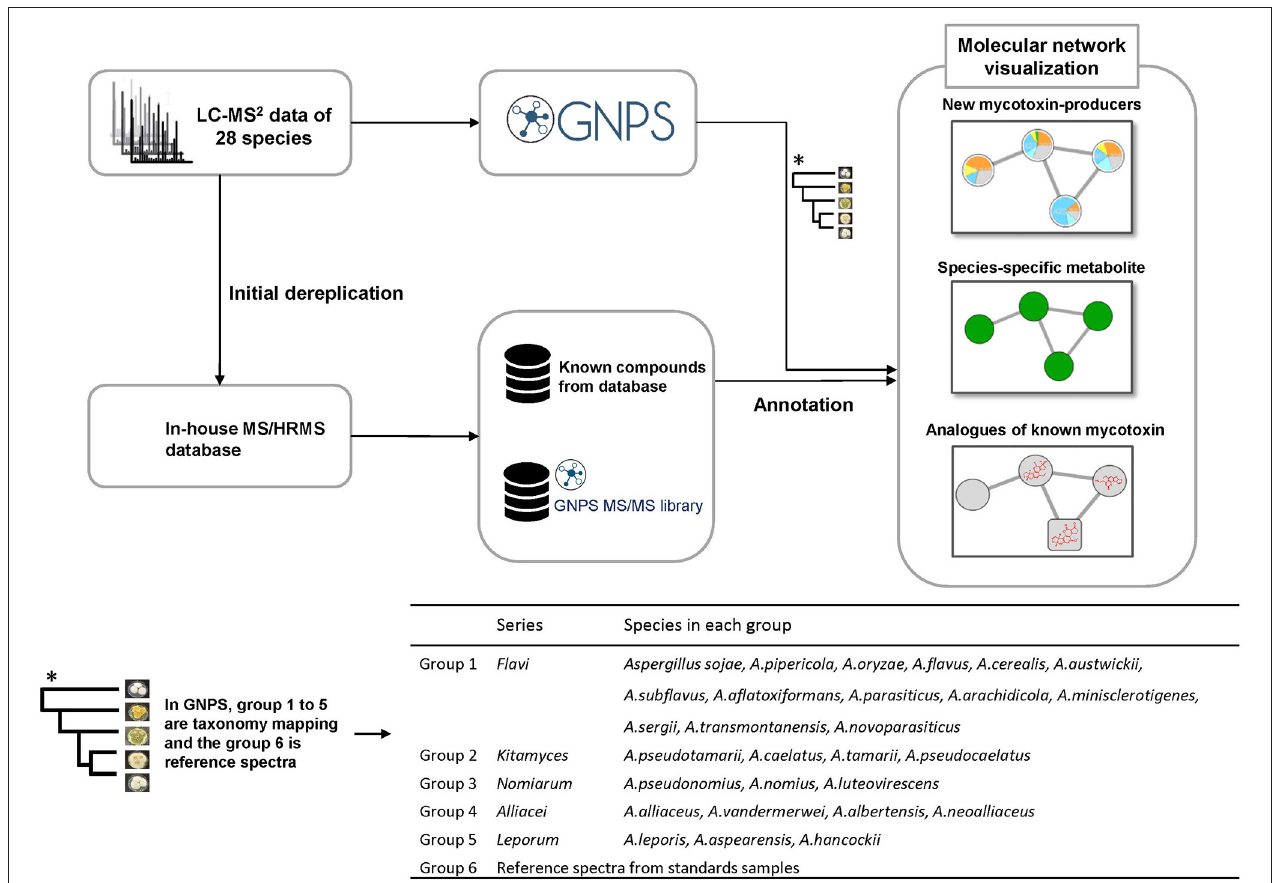
FIGURE 1 | Workflow procedure used in this study.